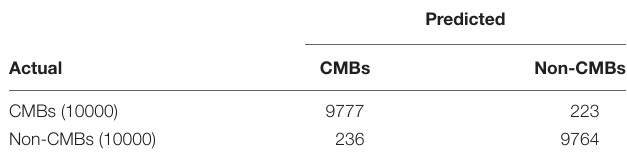
TABLE 2 | Confusion matrix of detected CMB and